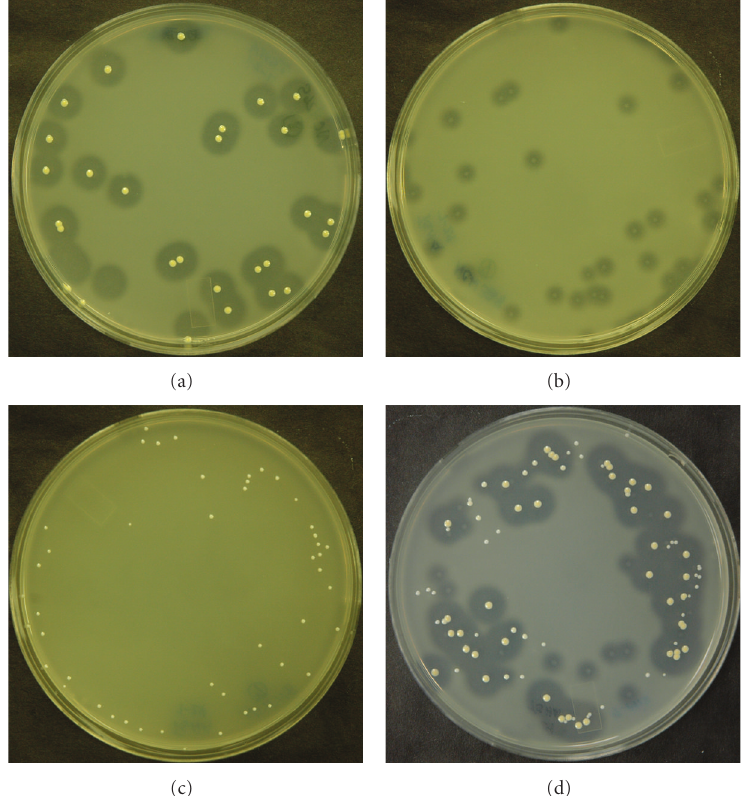
Figure 4: Hyaluronidase detection on tryptic soy agar supplemented with hyaluronic acid. S. aureus ATCC 33753 (a), S. aureus Newman (b), S. epidermidis ATCC 12228 (c), and a mixture of all three (d). Colonies of S. aureus Newman did not adhere to the agar surface when acetic acid was removed from the plates for photographic